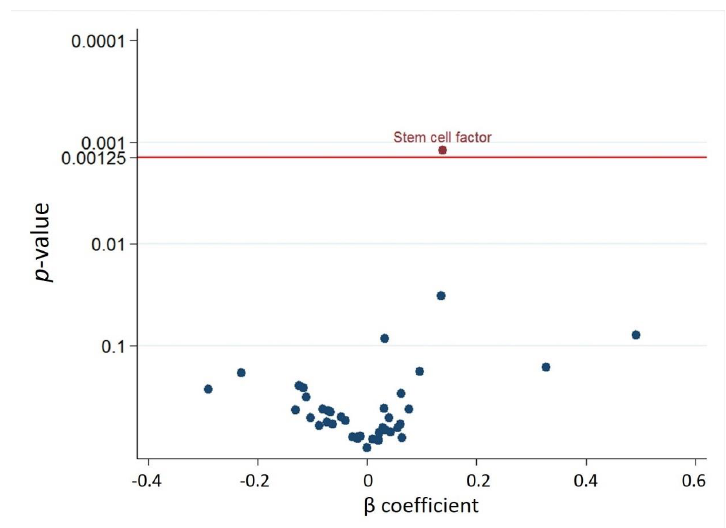
Figure 3. Volcano plot of the p -value and β coefficient for Indole-3-acetic acid and 40 MAPK cascade associated proteins association with false discovery rate <5% multiple testing control.